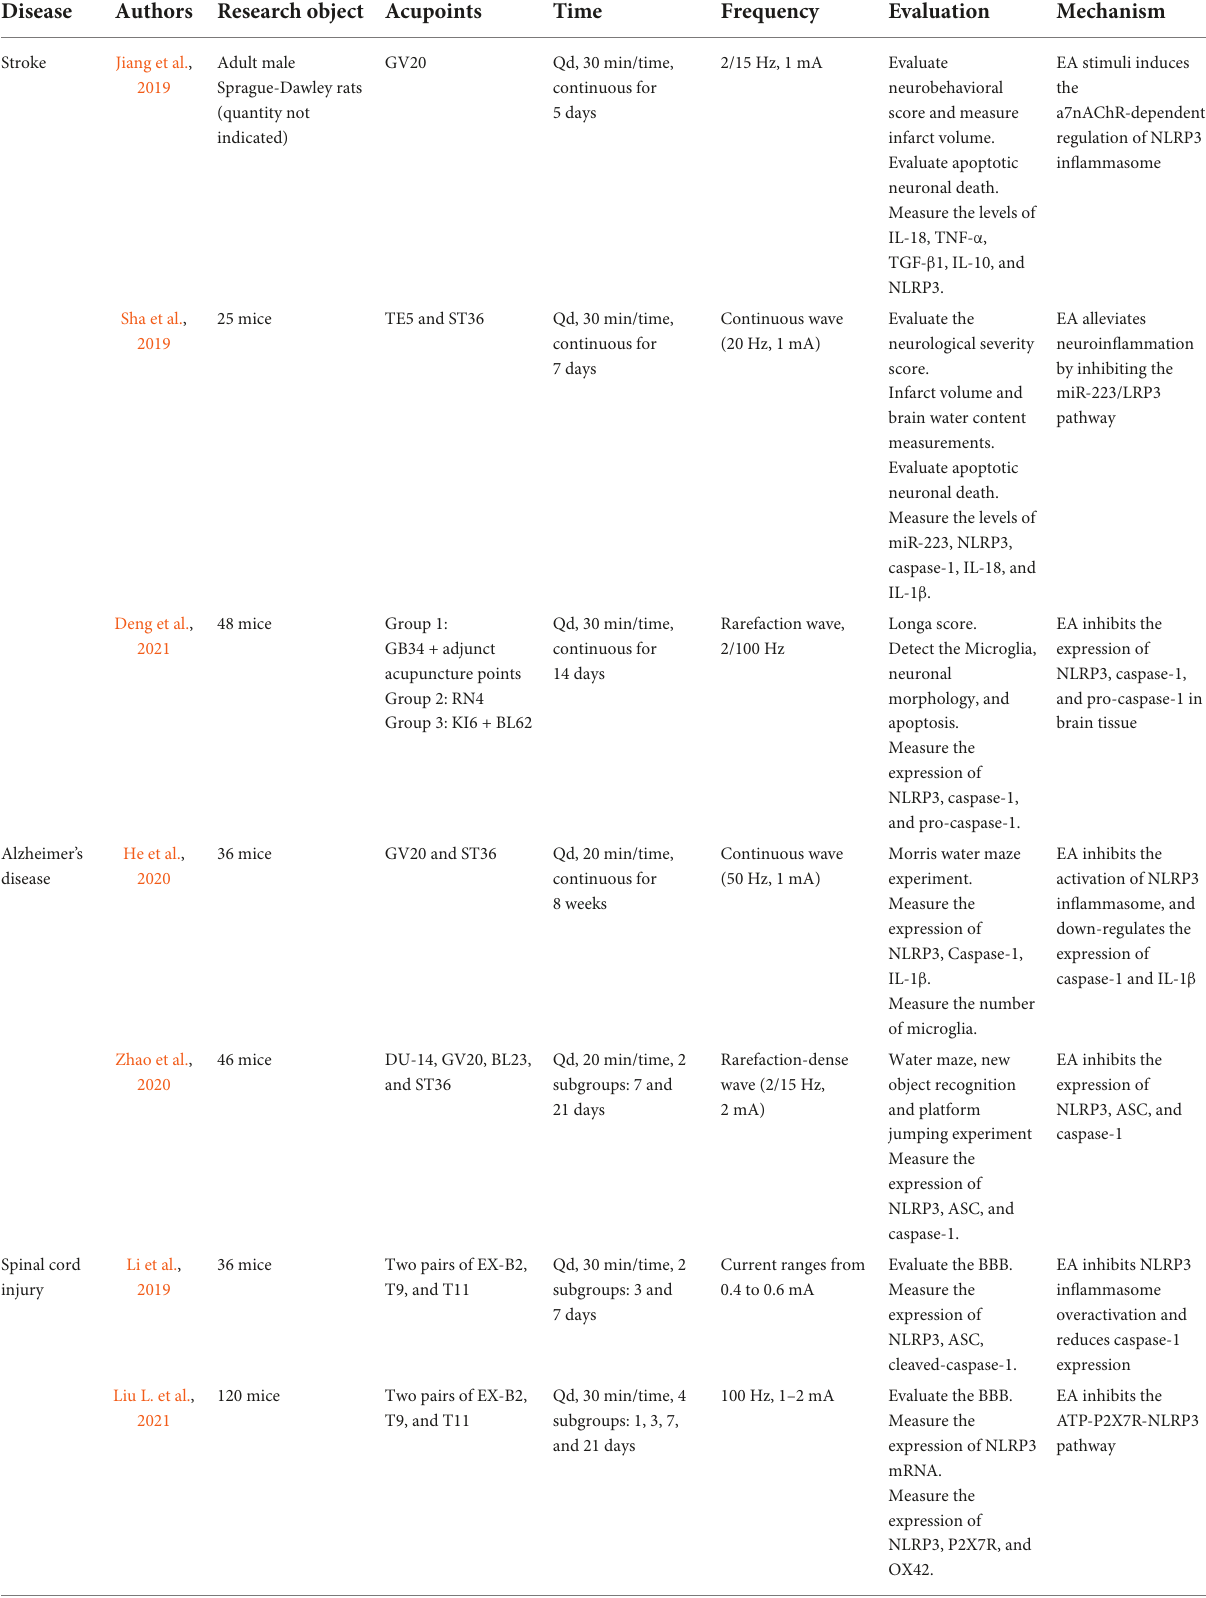
TABLE 2 Mechanism of electroacupuncture targeting NLRP3 inflammasome in the treatment of stroke, Alzheimer’s disease and spinal cord injury.